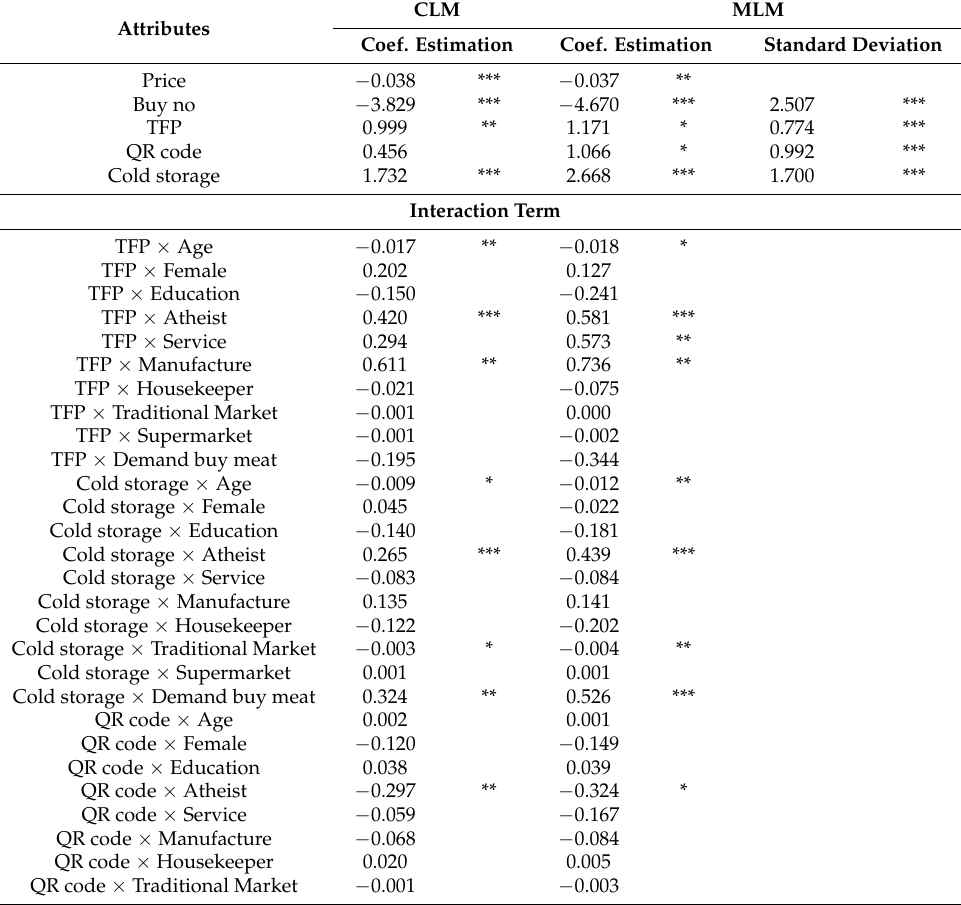
Table 3. The estimation of the Mixed Logit Model (MLM) and Conditional Logit Model (CLM). CLM MLM Attributes Coef. Estimation Coef.